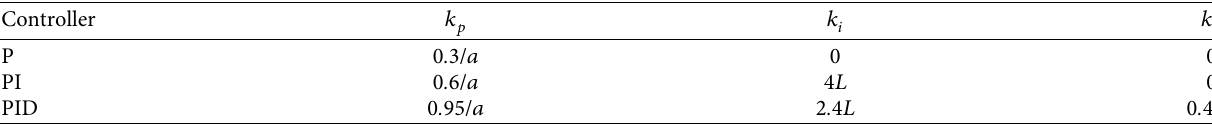
Table 2: The Chien–Hrones–Reswick autotuning method focuses on set point response and disturbance response (20% overshoot) [51]. Controller